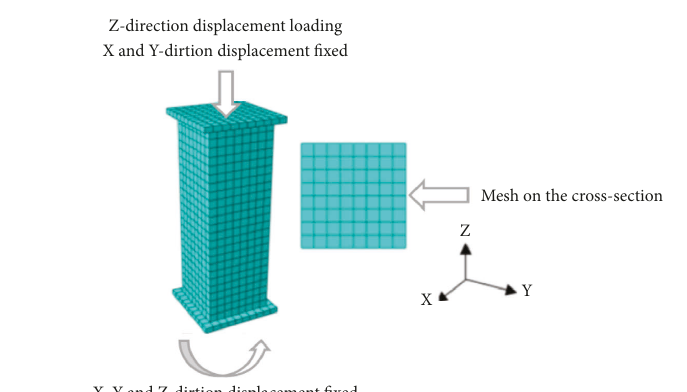
Figure 3: Failure mode of specimens.